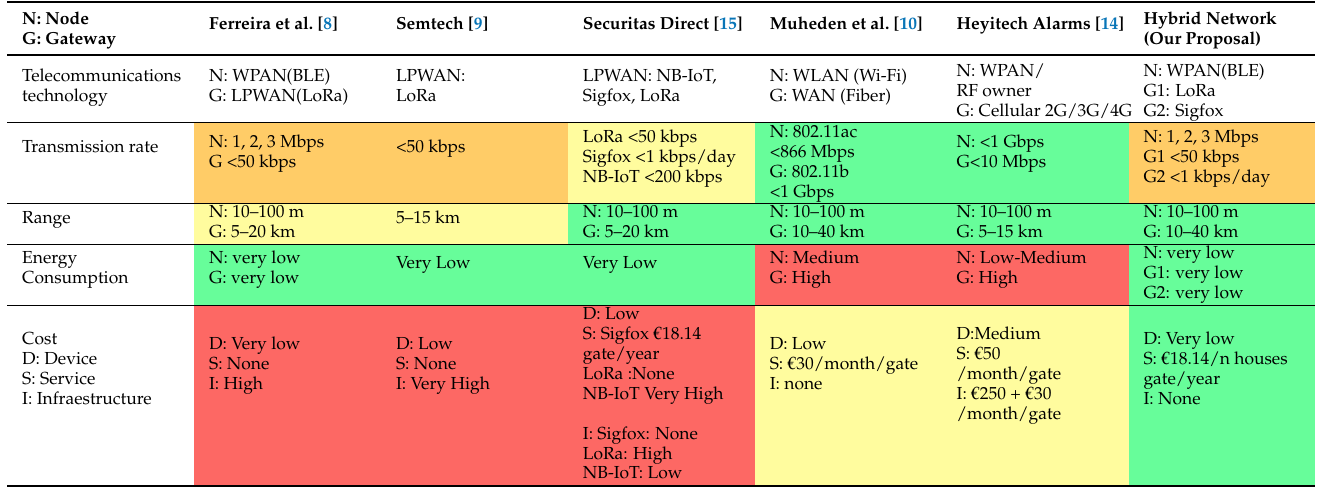
Table 1. Relevant characteristics and comparison between the state of the art and the proposed system. Features: worst (red), poor (orange), medium (yellow), and best